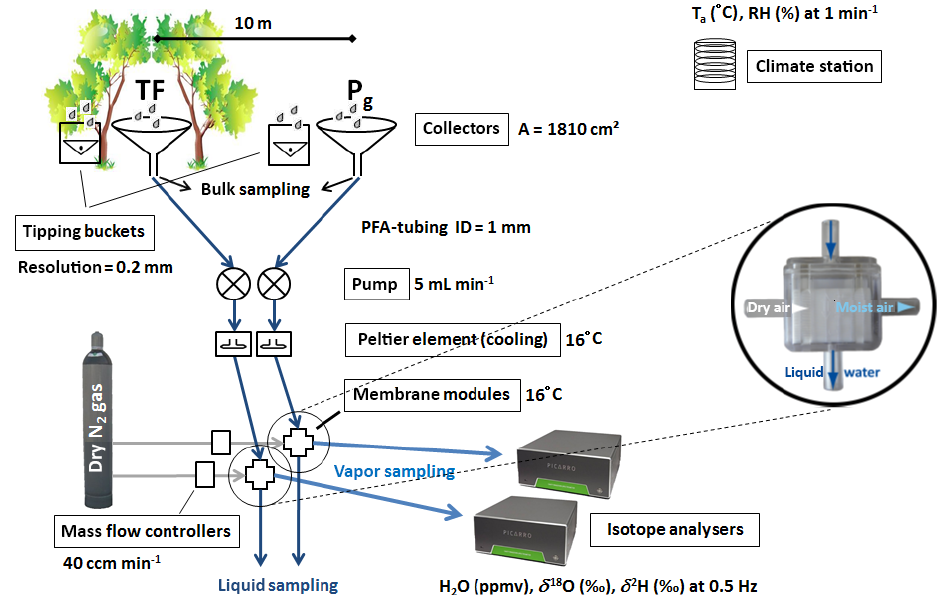
Figure 1. Setup for continuous water vapour stable isotope measurements of gross precipitation (P g ) and throughfall (TF) with two analysers in parallel; membrane contactor (centre-right) employed for continuous production of water vapour; discrete liquid and liquid bulk sampling of P g and TF; recording of rainfall depth (tipping buckets, upper left) and the meteorological variables T a and RH (upper right) every minute.